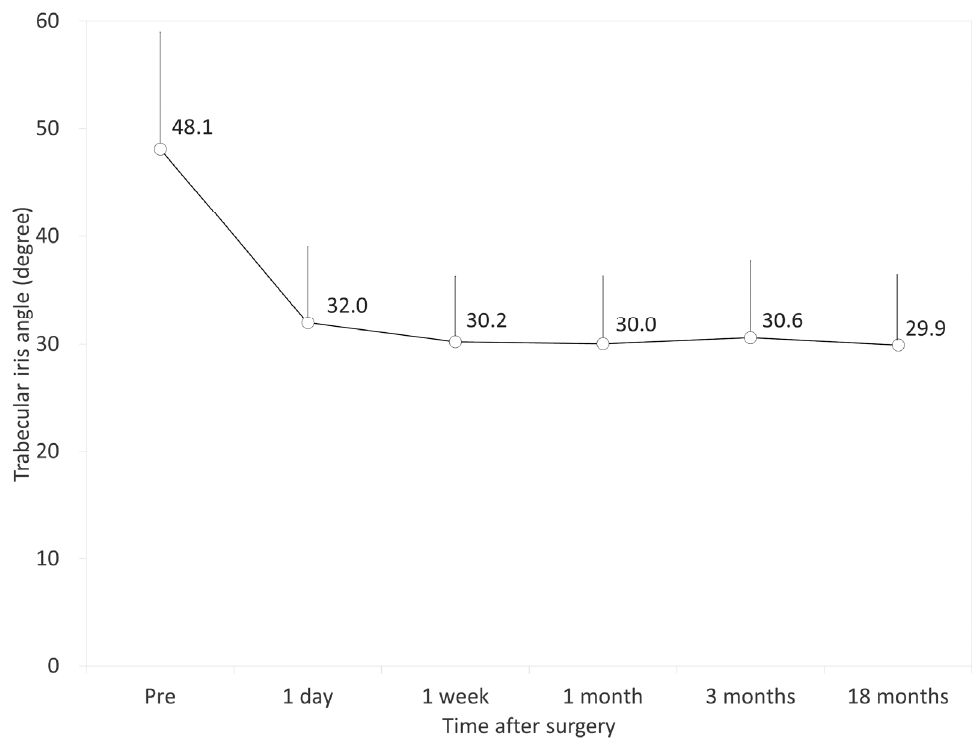
Figure 3. Time course of trabecular-iris space area at 500 µm (TISA500) after implantable collamer lens (ICL) implantation. The TISA500 was significantly decreased 1 day postoperatively and subsequently stabilized over time. Bar represents standard deviation.